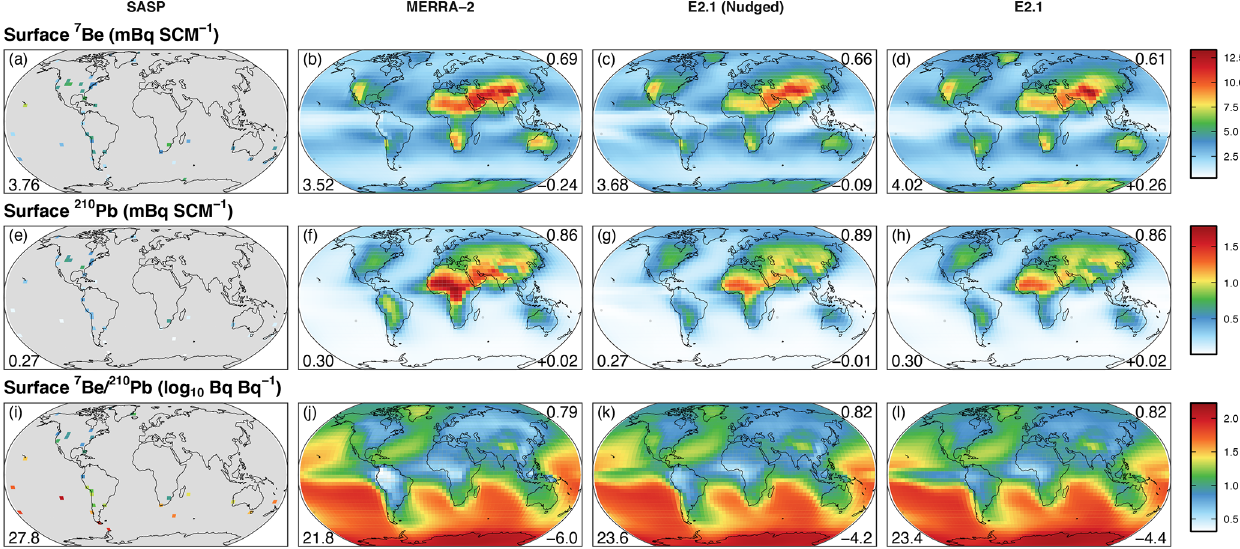
Figure 11. Surface mixing ratios of 7 Be (top row; in mBq SCM − 1 ; 4.05mBqSCM − 1 = 1.0 × 10 − 21 mol 7 Be(mol air) − 1 ), 210 Pb (middle row; in mBq SCM − 1 ; 2.66mBqSCM − 1 = 1.0 × 10 − 19 mol 210 Pb(mol air) − 1 ), and the log 10 -transformed ratio of the 7 Be to 210 Pb activities in surface air (bottom row; unitless). The left column shows long-term mean observations from the DOE Surface Air Sampling Program (SASP) program for 1969–1999CE. The 7 Be observations have been selected for periods of average solar activity ( (cid:56) = 670 ± 50MV from Usoskin et al., 2005). The three columns on the right show (from left to right) values simulated by GEOS-Chem driven by meteorology archived for 2005–2014CE from MERRA-2, E2.1 nudged to MERRA-2, and the free-running E2.1. The number in each panel’s lower left shows the mean value of the observations or models sampled at the observed locations. The top right number shows the pattern correlation ( R ) of the simulated values with the respective observations. The lower right number shows the mean bias of the simulated values with respect to the observations.